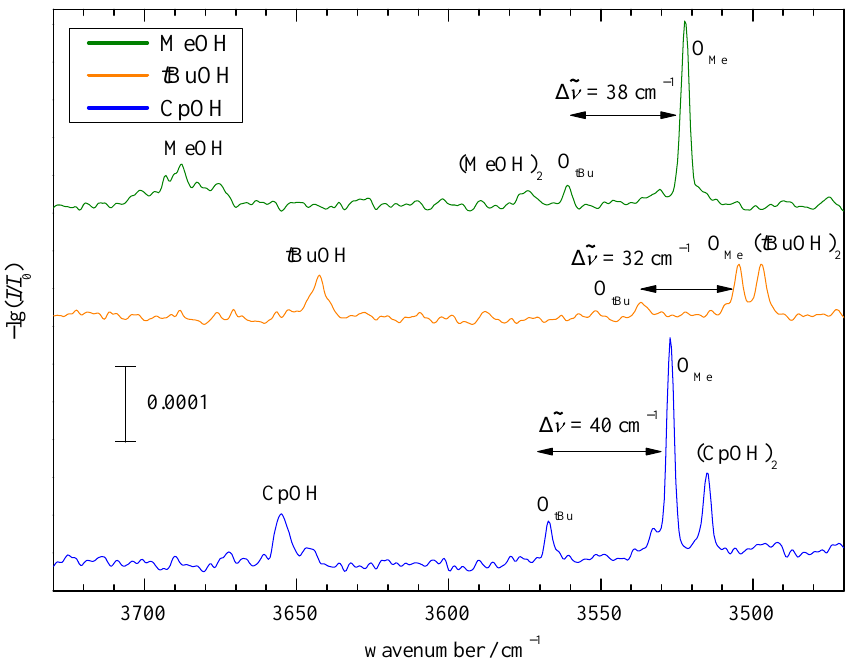
Figure 4. FTIR jet OH stretching spectra of Pin with the three alcohols. The 1:1 complexes are marked with O, indexed by the assigned docking preference. Both docking sides are observed. Pin is only a stronger OH shifting partner than the alcohol itself for